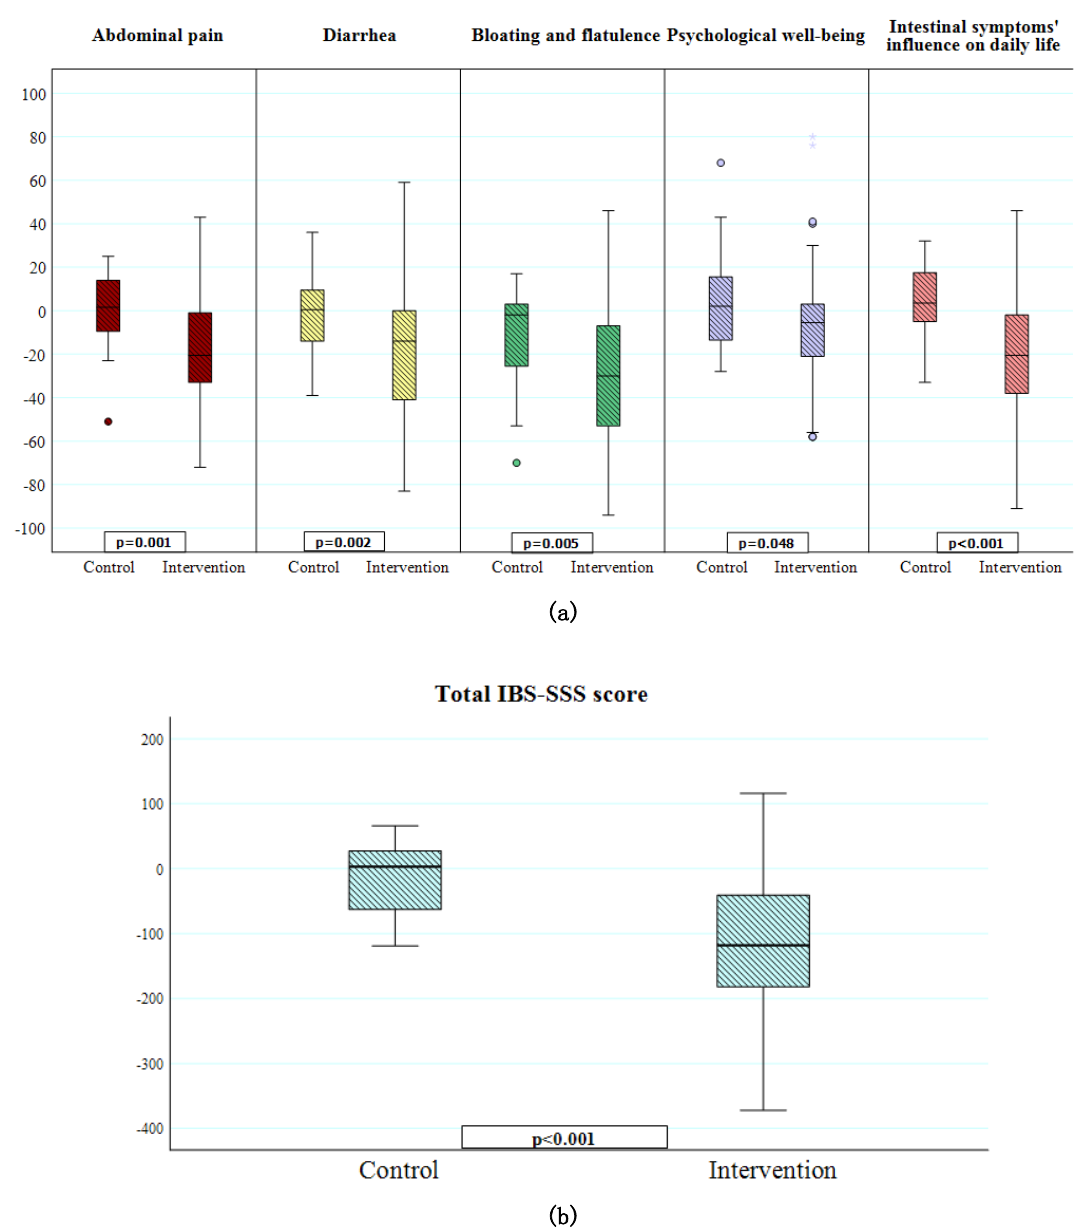
Figure 1. Changes in symptoms after the two-week dietary intervention. ( a ) Di ff erences in the change of visual analog scale for irritable bowel syndrome (VAS-IBS) symptom scores (delta values) between controls ( n = 25) and the intervention group ( n = 80) regarding abdominal pain, diarrhea, bloating and flatulence, psychological well- being and intestinal symptoms’ influence on daily life. A score of 100 indicates the highest level of GI symptoms, very poor psychological well-being and high influence of symptoms on daily life. Missing values in two controls and five from the intervention group. Mann-Whitney U test. p < 0.05 was considered statistically significant. (b) Difference in the change of total irritable bowel syndrome-symptom severity scale (IBS-SSS) scores (delta values) between controls ( n = 25) and the intervention group ( n = 80). Missing values in two controls and five from the intervention group. Mann-Whitney U test. p < 0.05 was considered statistically significant.